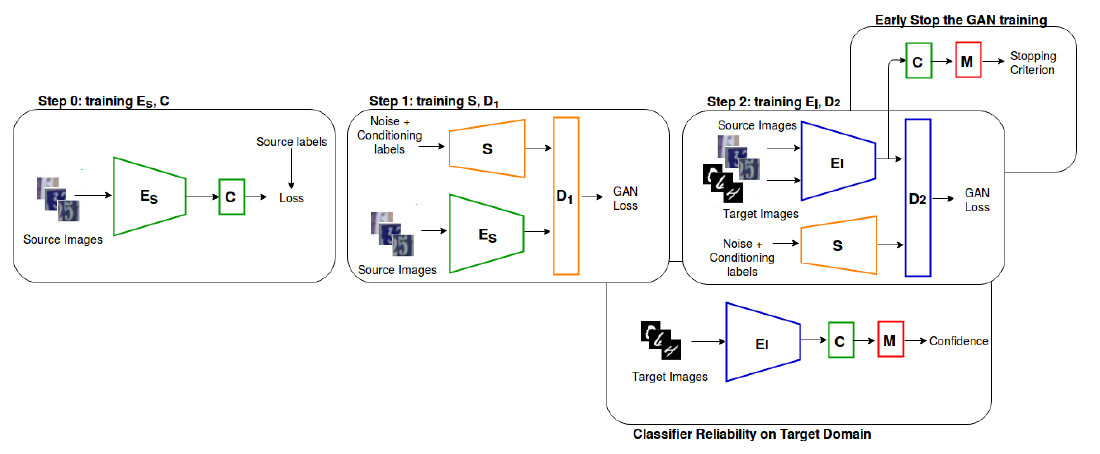
Figure 1. Domain adaptation network